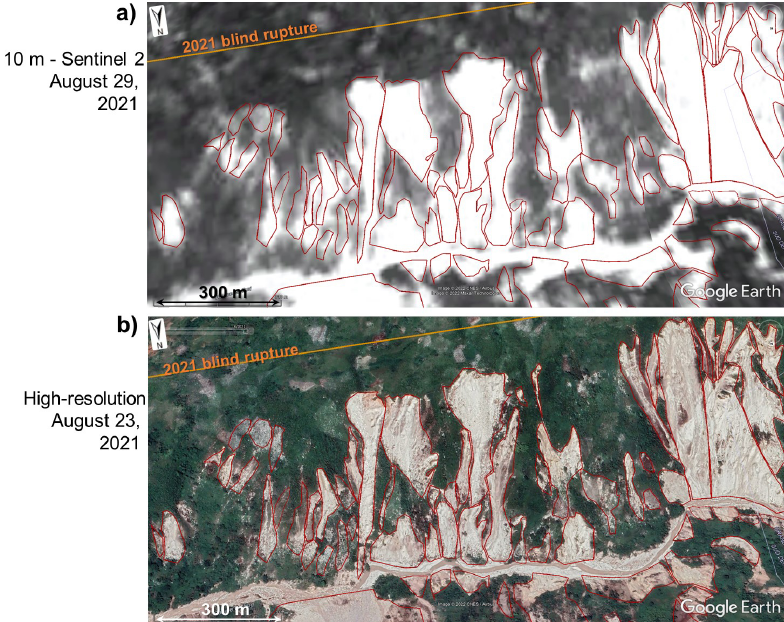
Figure A2. Comparison between (a) a Sentinel-2 image (10m resolution) and (b) a high-resolution ( ∼ 0 . 5–1m) image (© Google Earth) of the same area affected by landslides triggered by the earthquake event in August